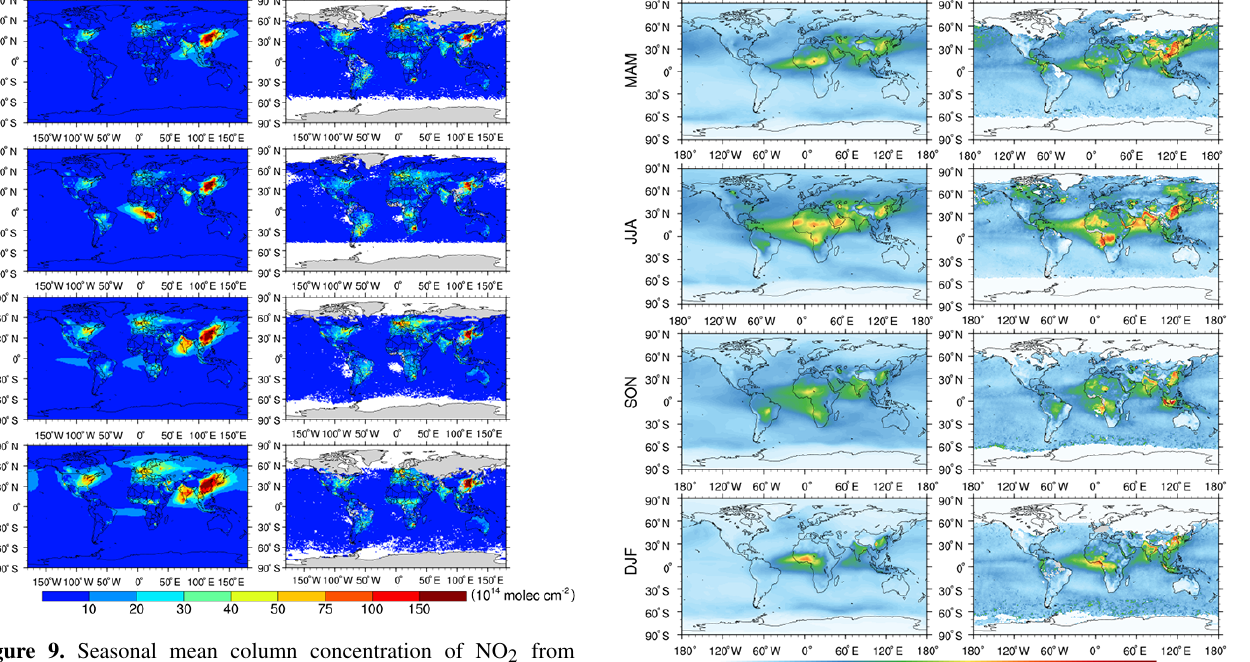
Figure 9. Seasonal mean column concentration of NO 2 from IAP-AACM, left column, and GOME-2A, right column (in 10 14 moleccm − 2 ).